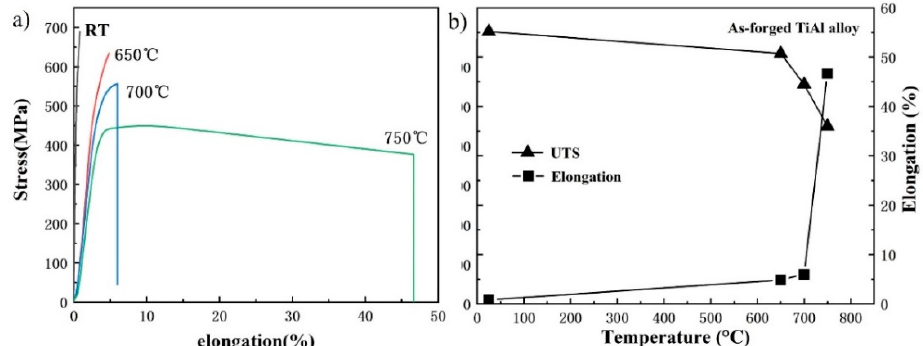
Figure9. Tensilepropertiesofthemulti-directionalforgedTiAlalloy. ( a )Tensilecurves, and( b )variation Figure 9. Tensile properties of the multi-directional forged TiAl alloy. ( a ) Tensile curves, and ( b ) of ultimate tensile strength (UTS) and δ with variation of ultimate tensile strength (UTS) and δ with temperature.